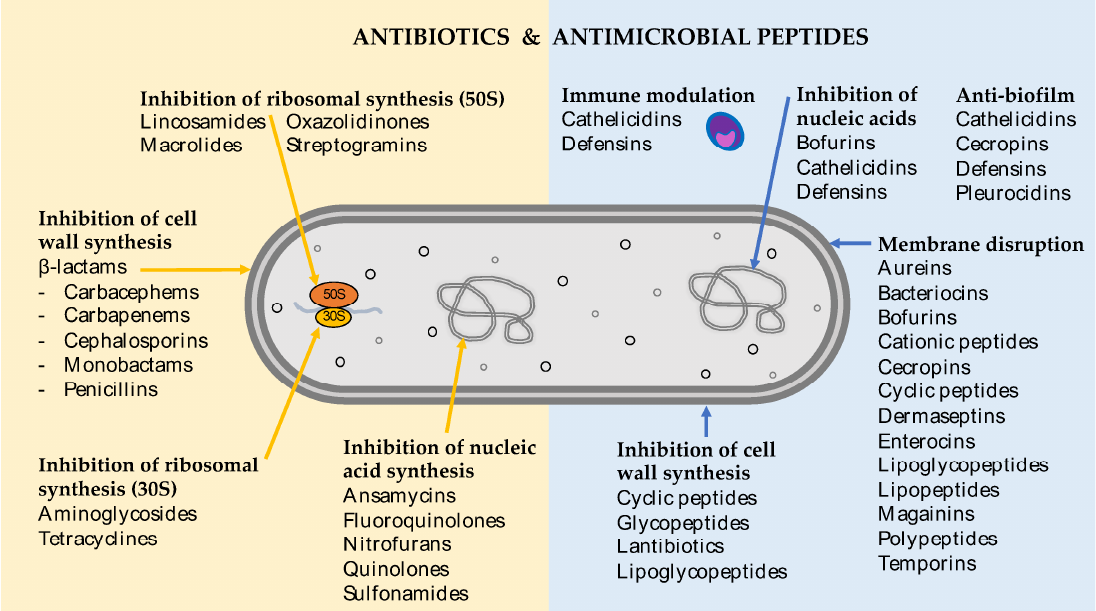
Figure 2. Mechanistic targets of antibiotics and antimicrobial peptides.